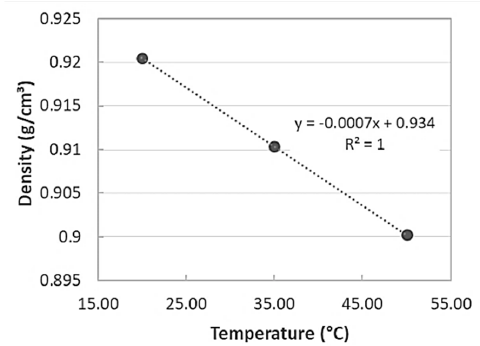
Figure 1. Temperature dependence of oil density.